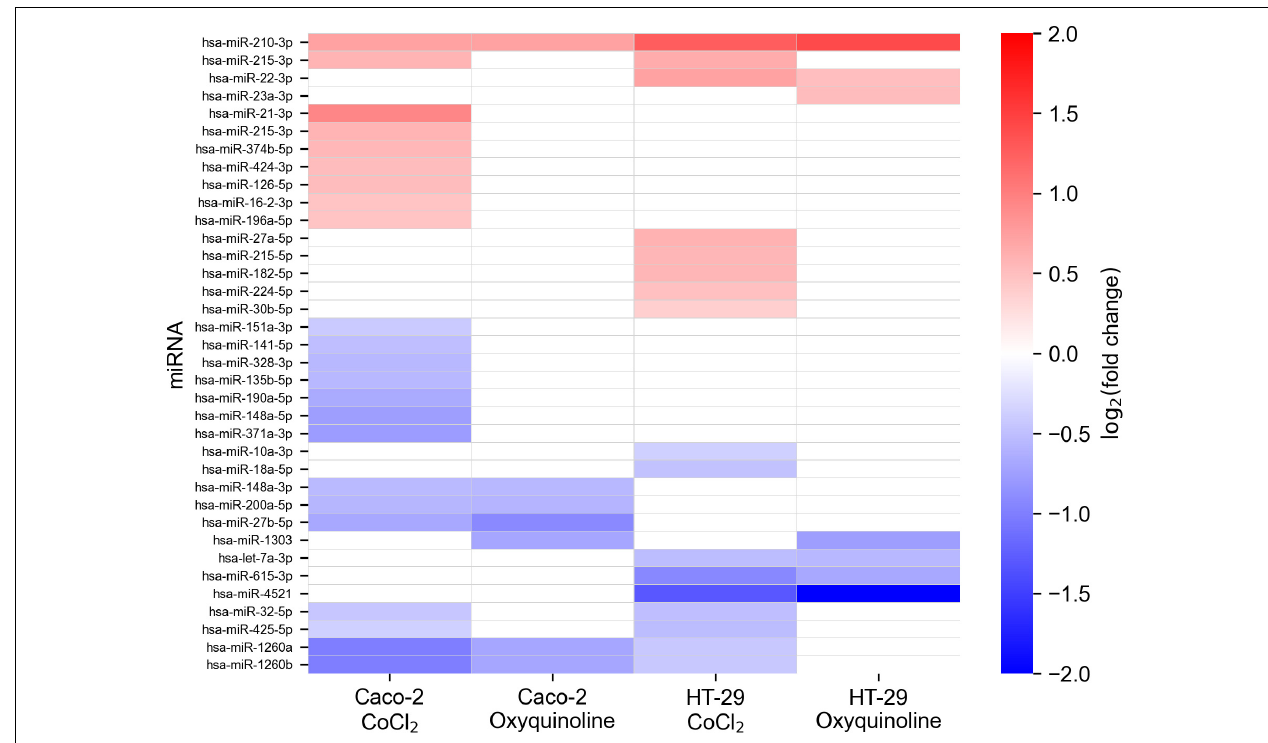
FIGURE 3 | Changes in miRNA expression levels of colorectal cell lines exposed to chemically simulated hypoxia. A miRNA is included in the plot in case if it is differentially expressed in at least one out of four experimental conditions. Empty cells correspond to miRNAs which were not differentially expressed or had not passed the thresholds on expression level (i.e., less